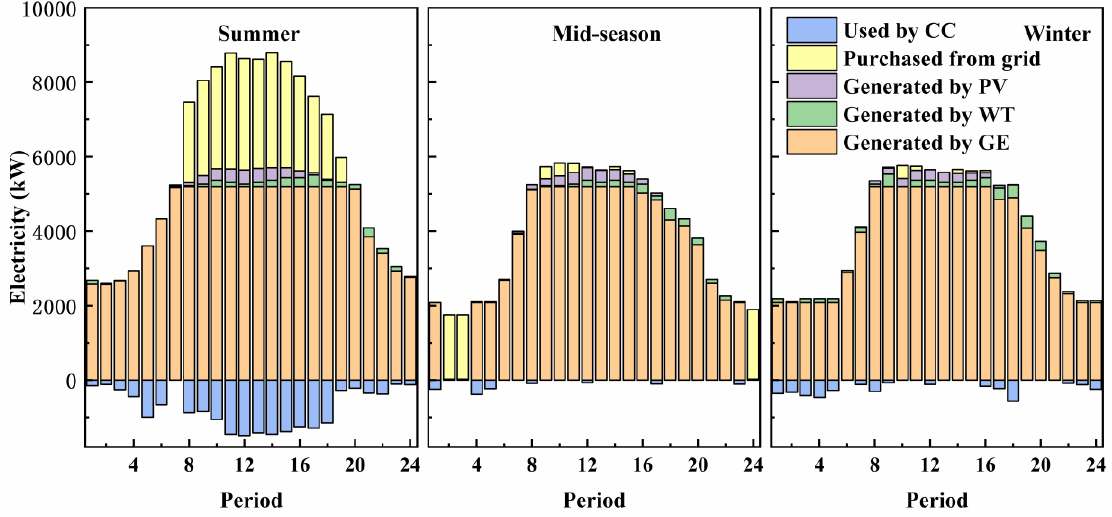
Figure 8. Electricity balance in Case 4 during the three typical